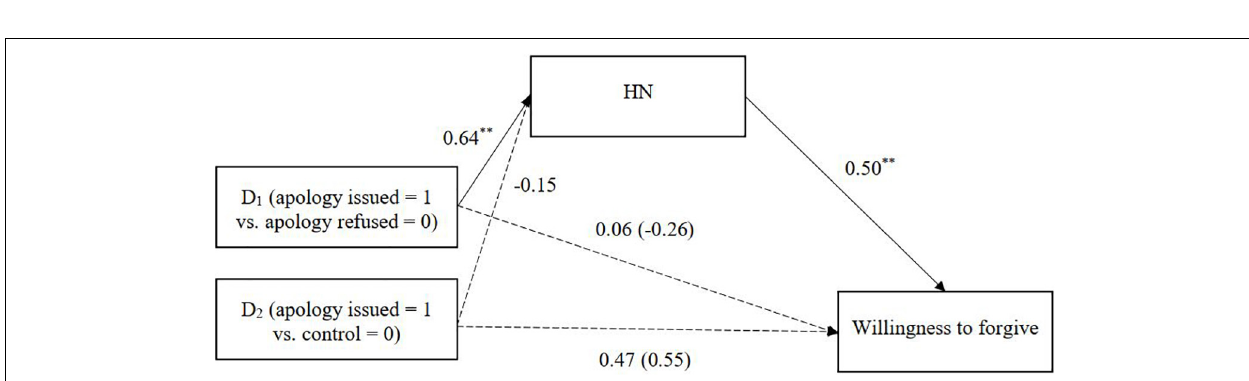
FIGURE 1 | HN mediating the relationship between condition and willingness to help (Study 1). Unstandardized coefficients are presented. Coefficients in parentheses denote direct effects after controlling for indirect effects. ∗∗ p < 0.01.